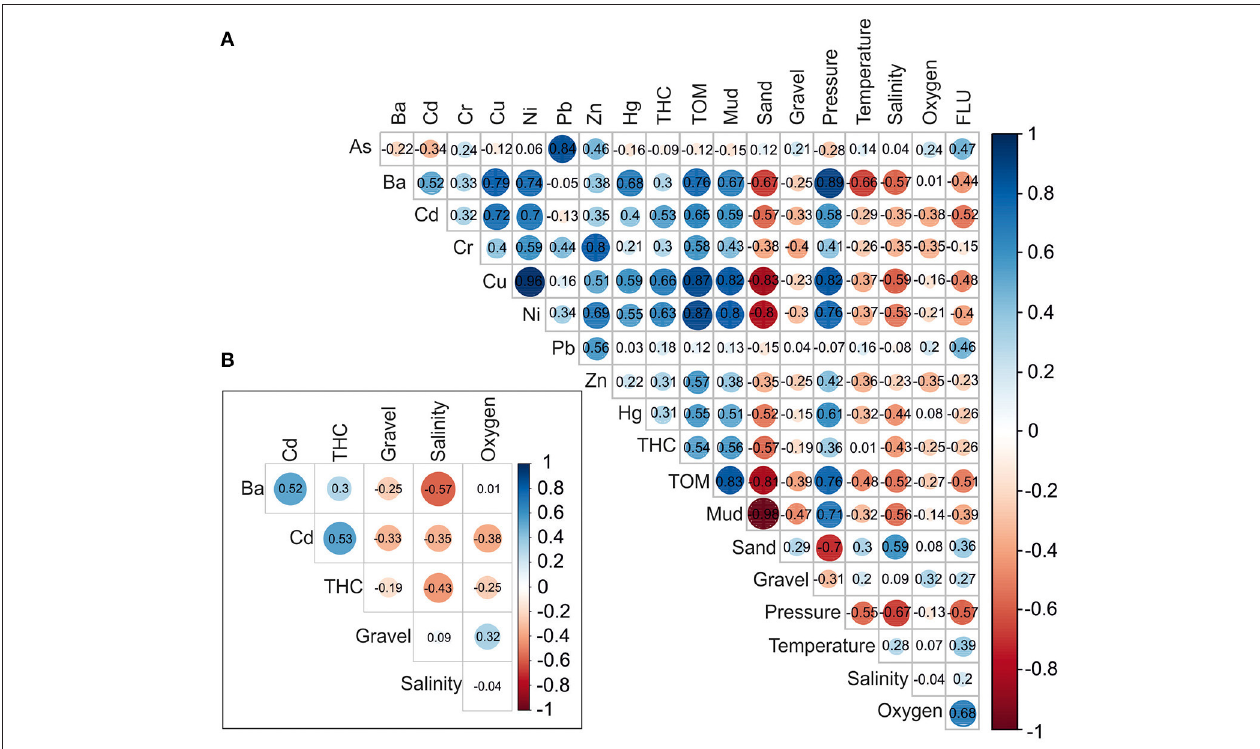
FIGURE 1 | Correlation matrices with Pearson‘s r correlation coefficients calculated for: (A) all predictors and (B) the least correlated predictors. For full list of environmental variables please see Supplementary Table 1 .